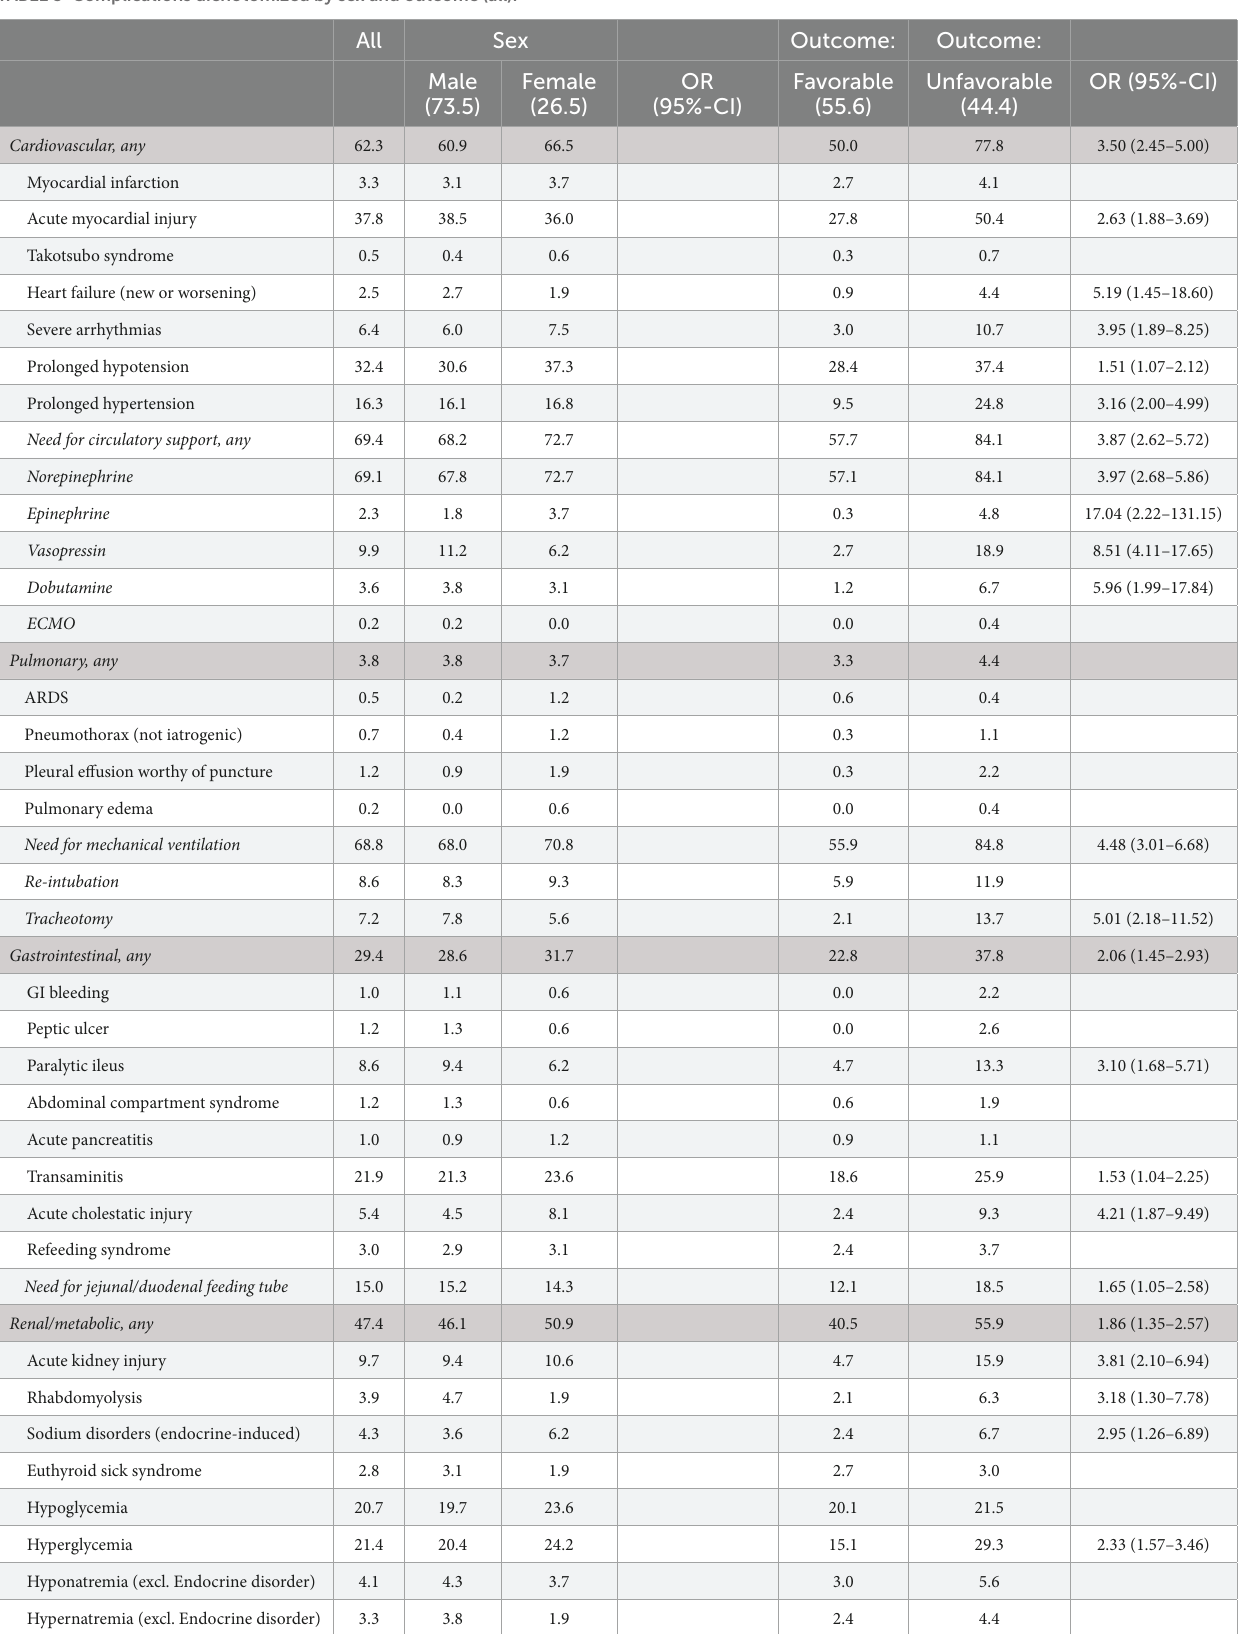
TABLE 3 Complications dichotomized by sex and outcome (all).